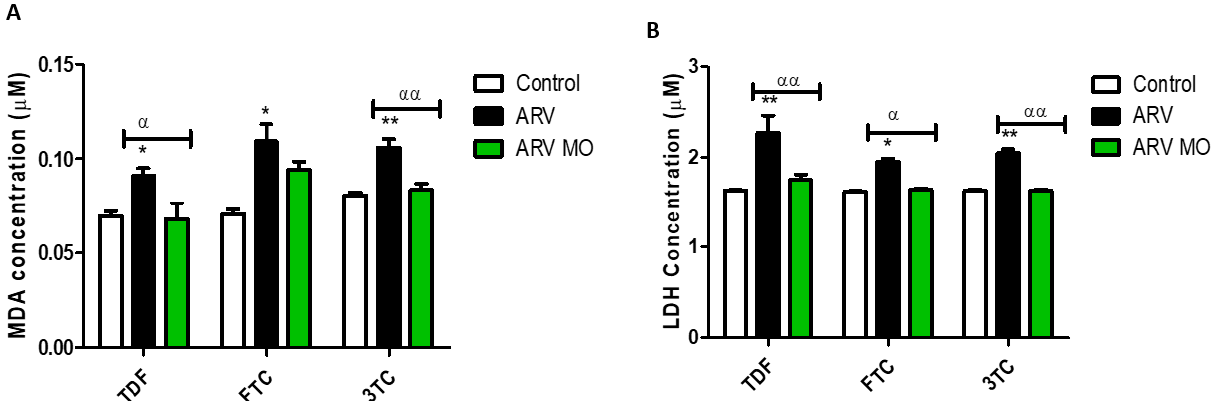
Figure 2. Assessment of cellular membrane integrity post-ARV and post-ARV MO treatment. ( A ) TDF, FTC, and 3TC significantly increased the levels of extracellular MDA, while ARV MO displayed a significant reduction in MDA in HepG2 cells. ( B ) ARVs significantly increased extracellular LDH, whereas ARV MO caused a significant reduction in LDH. * Represents a significant difference between the control and ARV (*, p < 0.05 and **, p < 0.001). α Represents a significant difference between ARV and ARV MO ( α , p < 0.05 and αα , p < 0.001).